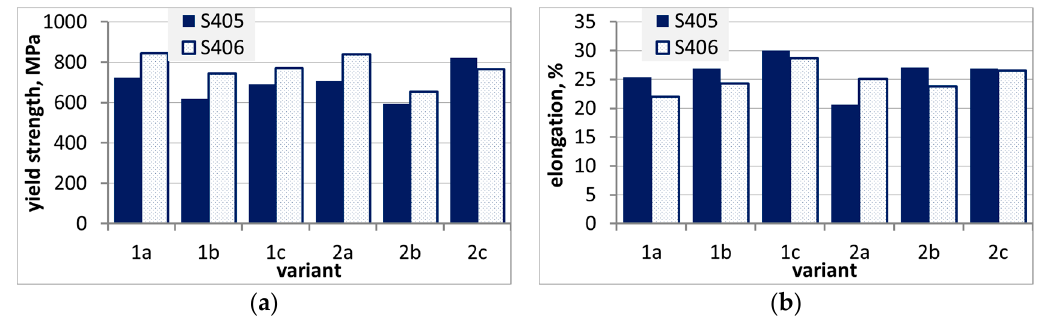
Figure 9. Yield strength ( a ) and elongation ( b ) of bainitic steels after various variants of physical simulation.